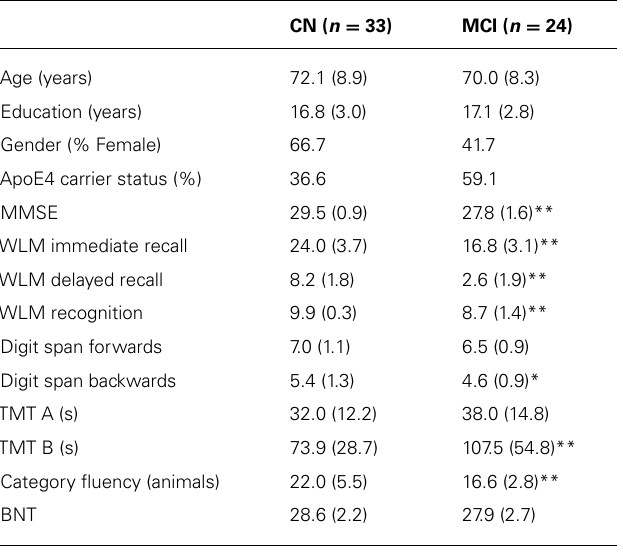
Table 1 | Demographic and psychometric